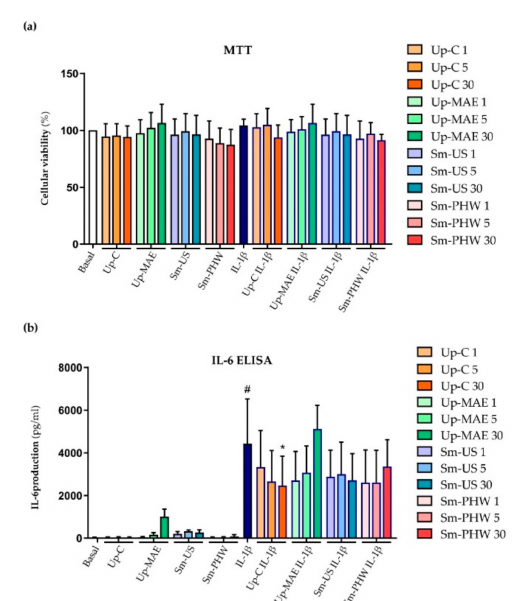
Figure 5. Effect of crude fucoidans and U. pinnatifida commercial fucoidan on cell viability ( a ) and inflammatory response ( b ) induced by IL-1 β in human primary chondrocytes. ( a ) Cell viability was measured by MTT assay ( n = 4) within the different experimental conditions: non-treated (basal) and treated with IL-1 β or Up-C, Up-MAE, Sm-US, and Sm-PHW at three different concentrations (1, 5, and 30 µ g/mL) with and without IL-1 β . ( b ) IL-6 production was measured at protein level by IL-6 ELISA ( n = 4) ( a ) in cells stimulated as previously indicated for 24 h. IL-1 β condition is statistically different from basal condition (#: p -value < 0.05). Conditions marked with * are statistically different from IL-1 β condition (*: p -value < 0.05).